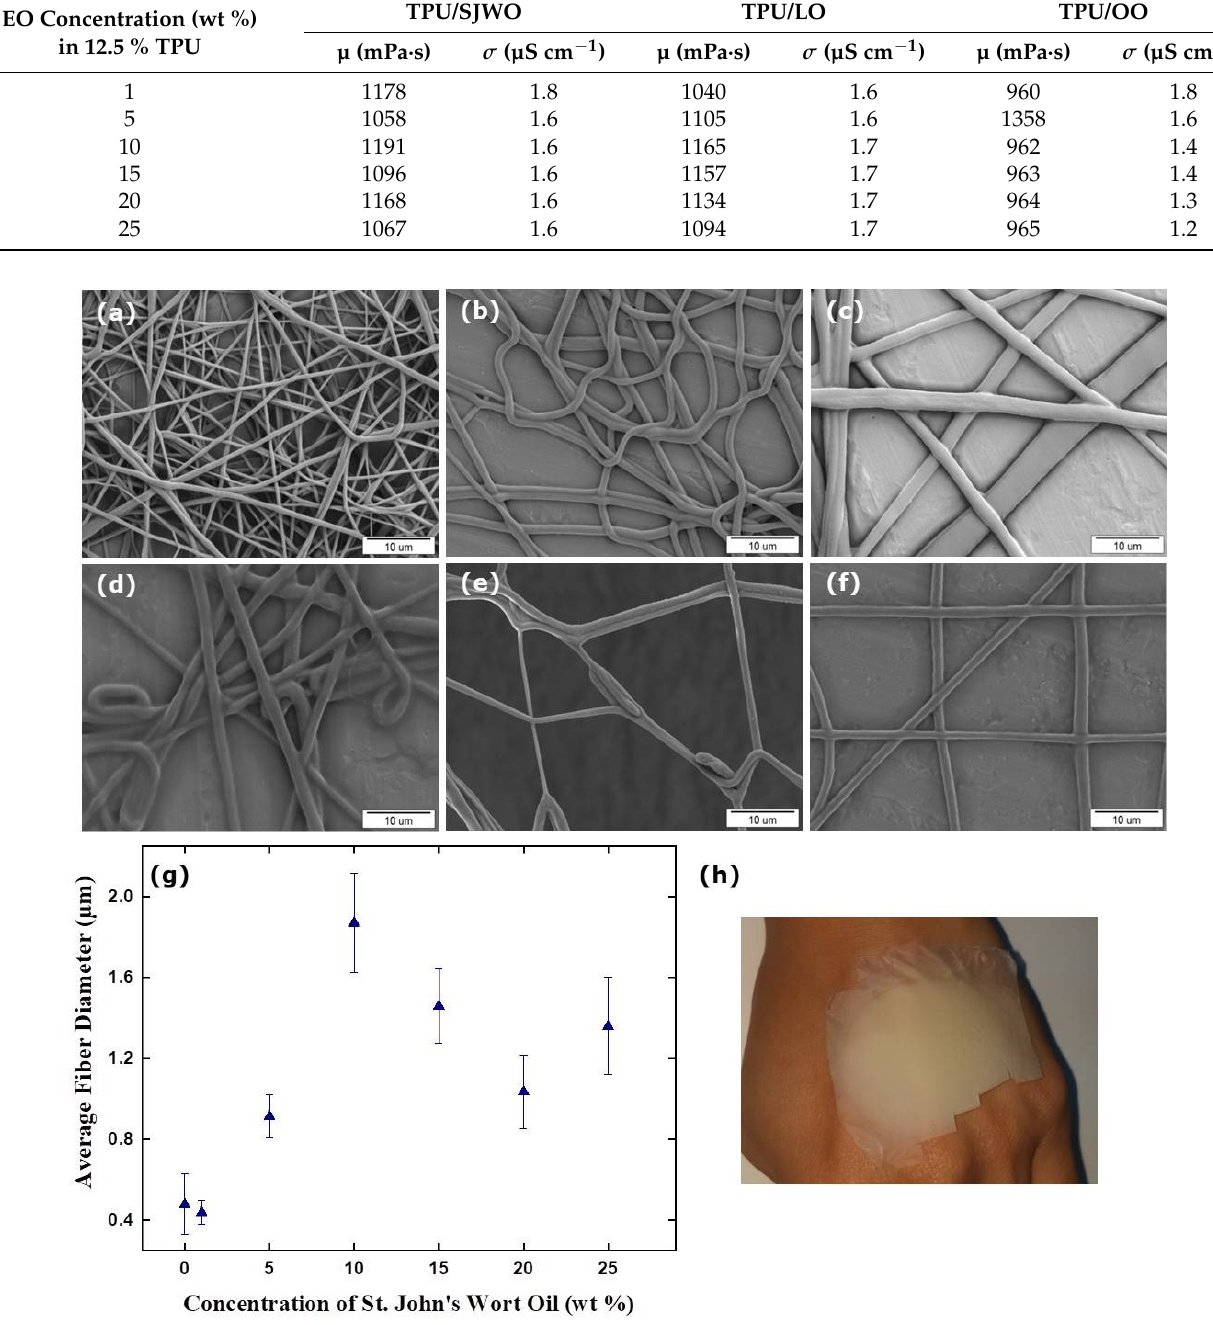
Figure 3. SEM micrographs with different concentrations of SJWO: ( a ) 1 wt %, ( b ) 5 wt %, ( c ) 10 wt %, ( d ) 15 wt %, ( e ) 20 wt %, ( f ) 25 wt %, the diameter distribution histogram ( g ), and photograph ( h ) of the TPU/SJWO fibers (applied voltage: 12.5 kV, flow rate: 1.00 mL h − 1 , distance: 17 cm, and TPU concentration in TPU/SJWO fibers: 12.5 wt